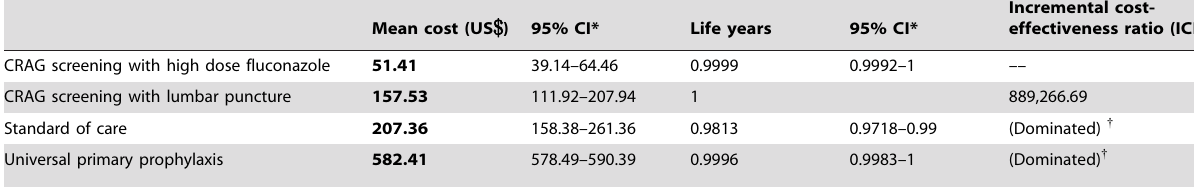
Table3(A). Cost-effectiveness of strategies to prevent cryptococcal meningitis in South Africa